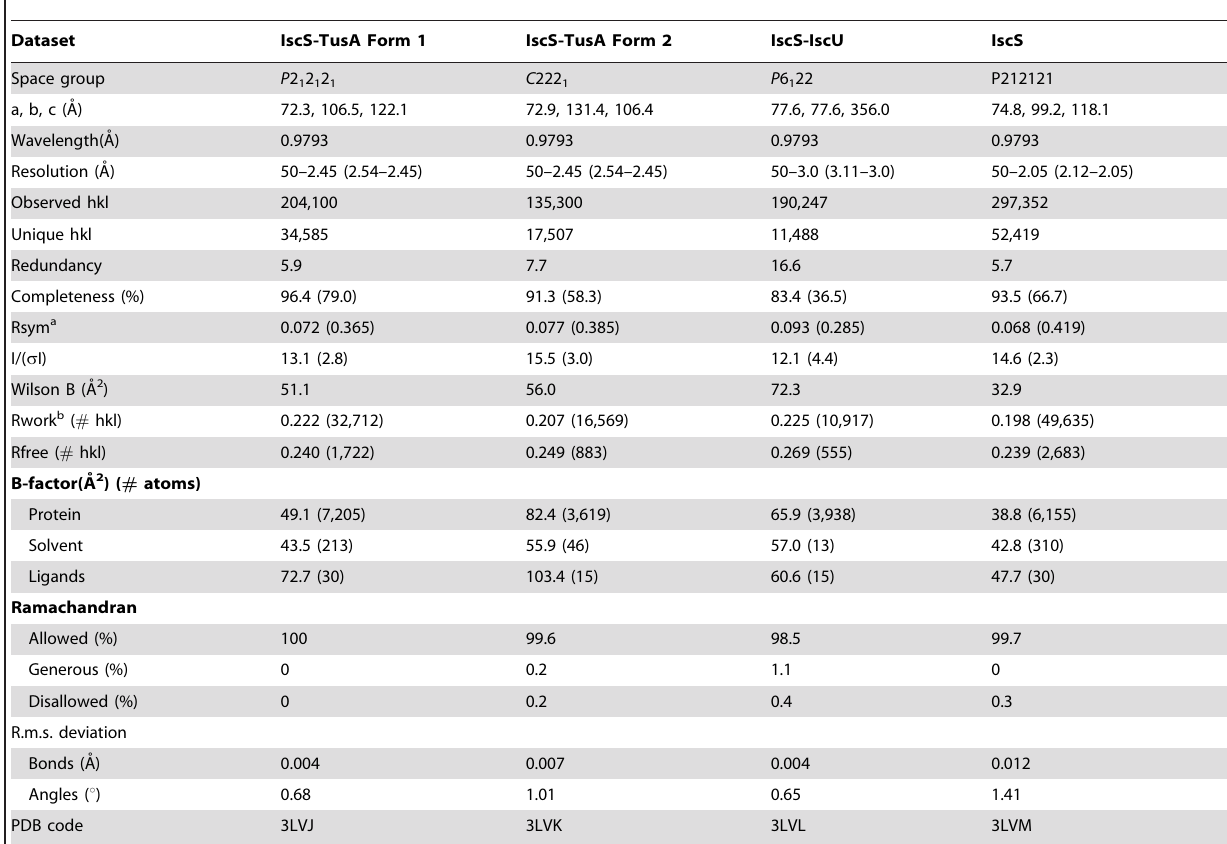
Table 1. X-ray data collection and refinement